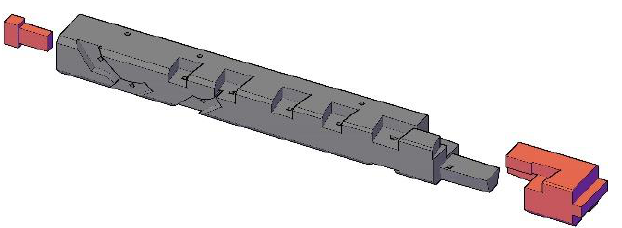
Figure 7. A 3D model beam (III) drawing of the structural repair of the damaged beam.